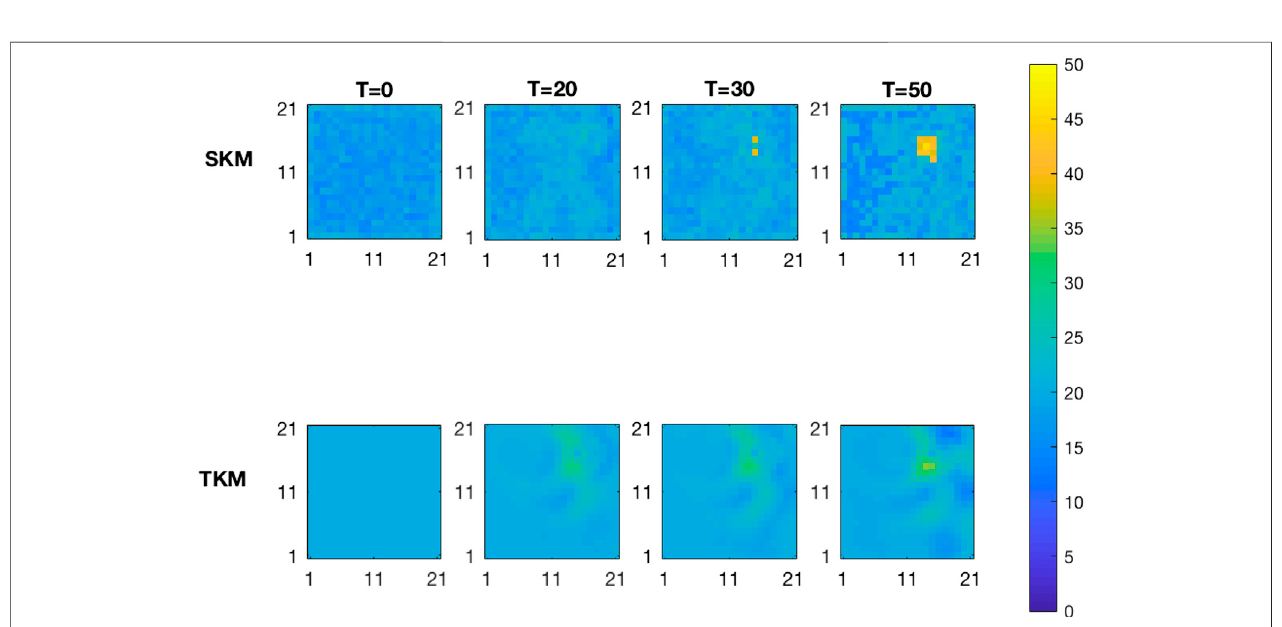
FIGURE 10 | MMAP predictions of the initial state for increasing current time T from the inversion with the selection Kalman model (SKM-upper) and with the traditional Kalman model (TKM-lower).